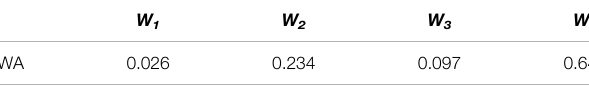
TABLE 6 | Coef fi cients of the WA operator.